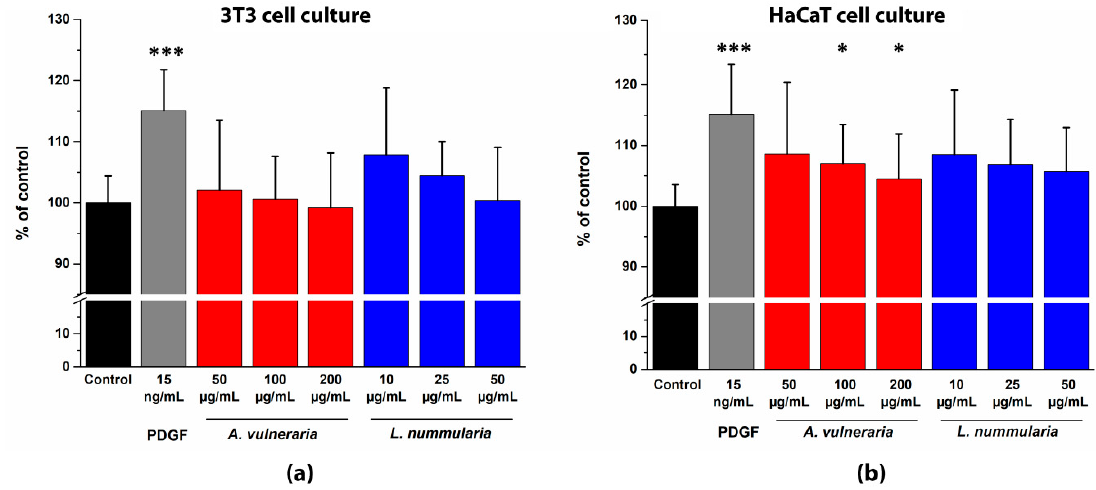
Figure 6. Comparative analysis by time-lapse imaging of wound closure ability of PDGF-BB and leaf extracts. ( a ) 50% ( v / v ) ethanolic extracts of A. vulneraria and L. nummularia on 3T3 monolayer cultures; ( b ) 50% ( v / v ) ethanolic extracts of A. vulneraria and L. nummularia on HaCaT monolayer cultures.